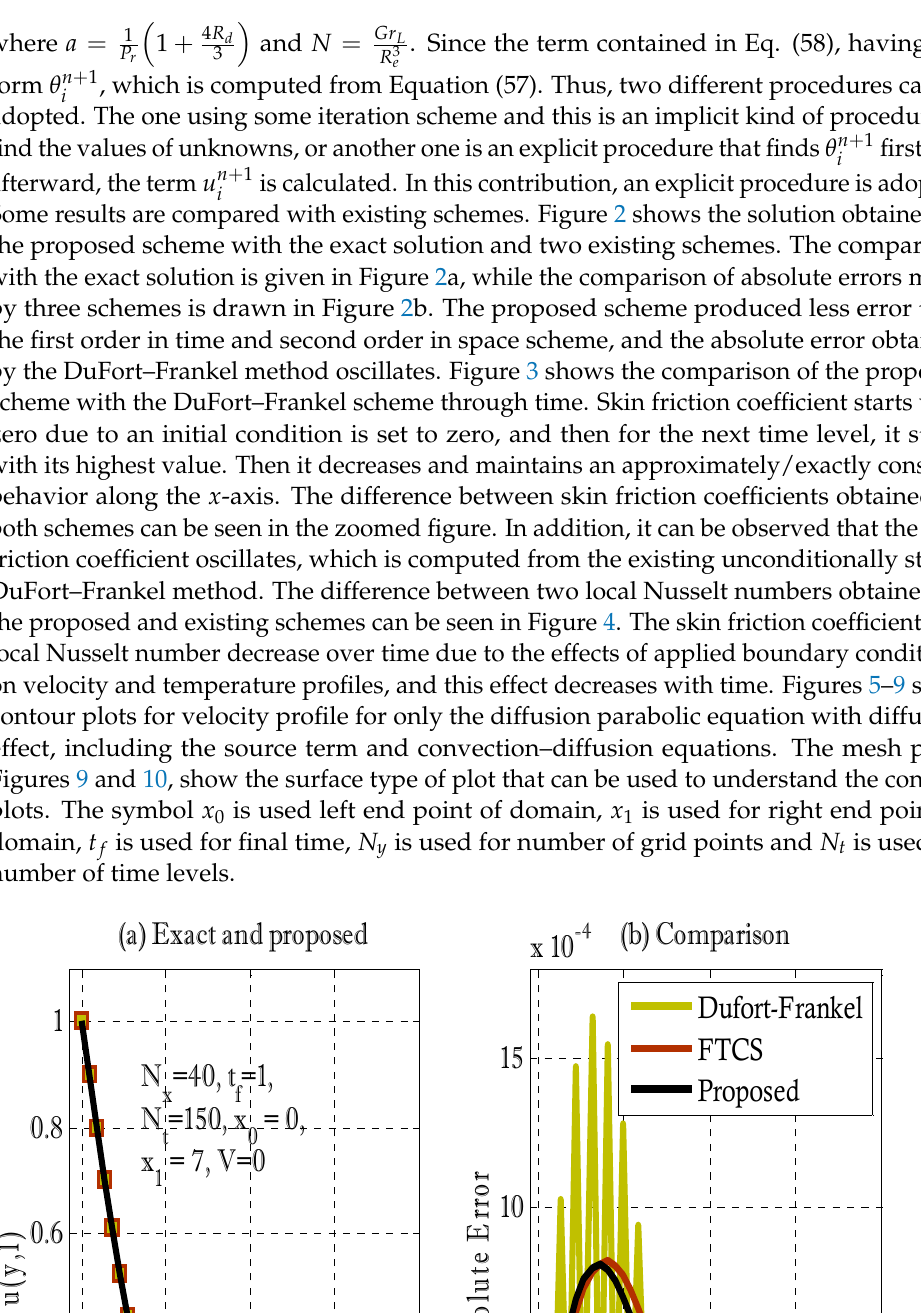
Figure 3. Comparison of the proposed scheme with the Dufort–Frankel method in finding the skin friction coefficient through time.